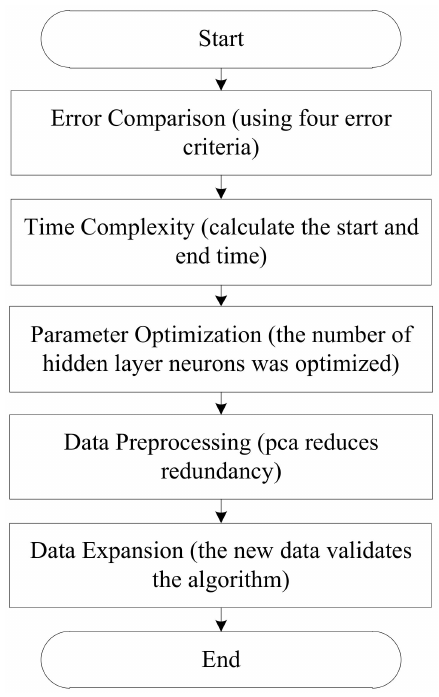
Figure 3. A schematic representation of the research